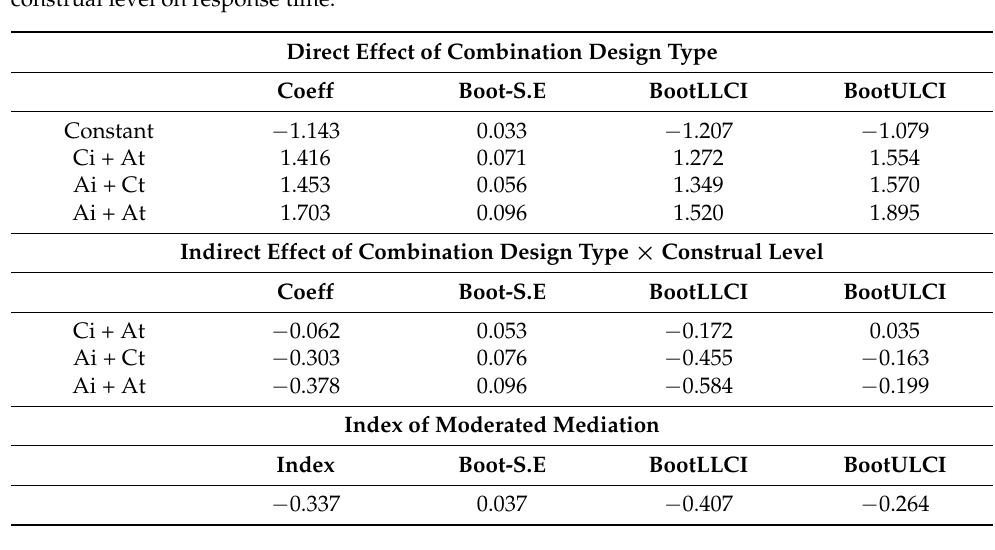
Table 5. The mediating role of the effects of cognitive fluency in combination design style and construal level on response time.